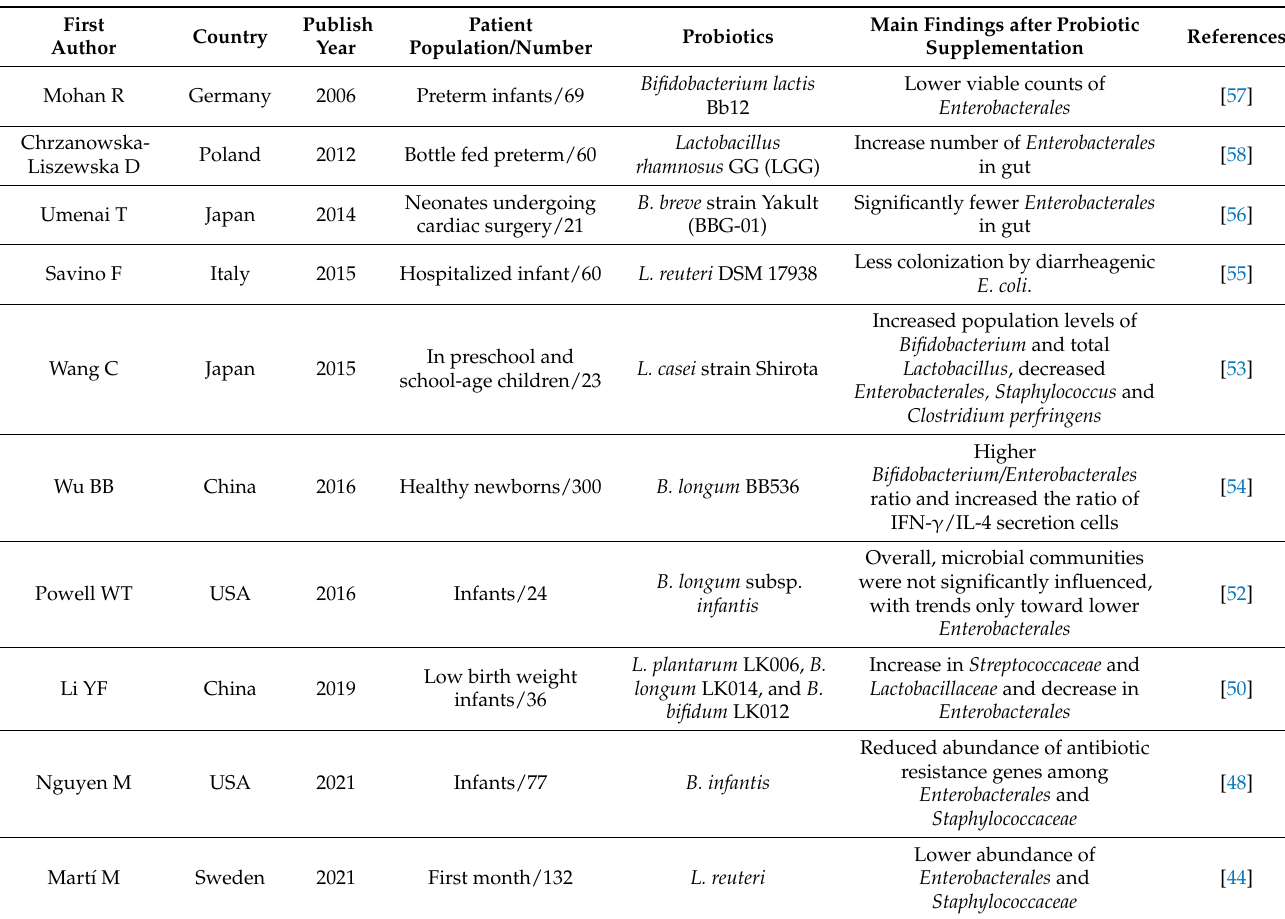
Table 1. Probiotic supplements for infants and children to decease potential pathogenic Enterobacterales in the